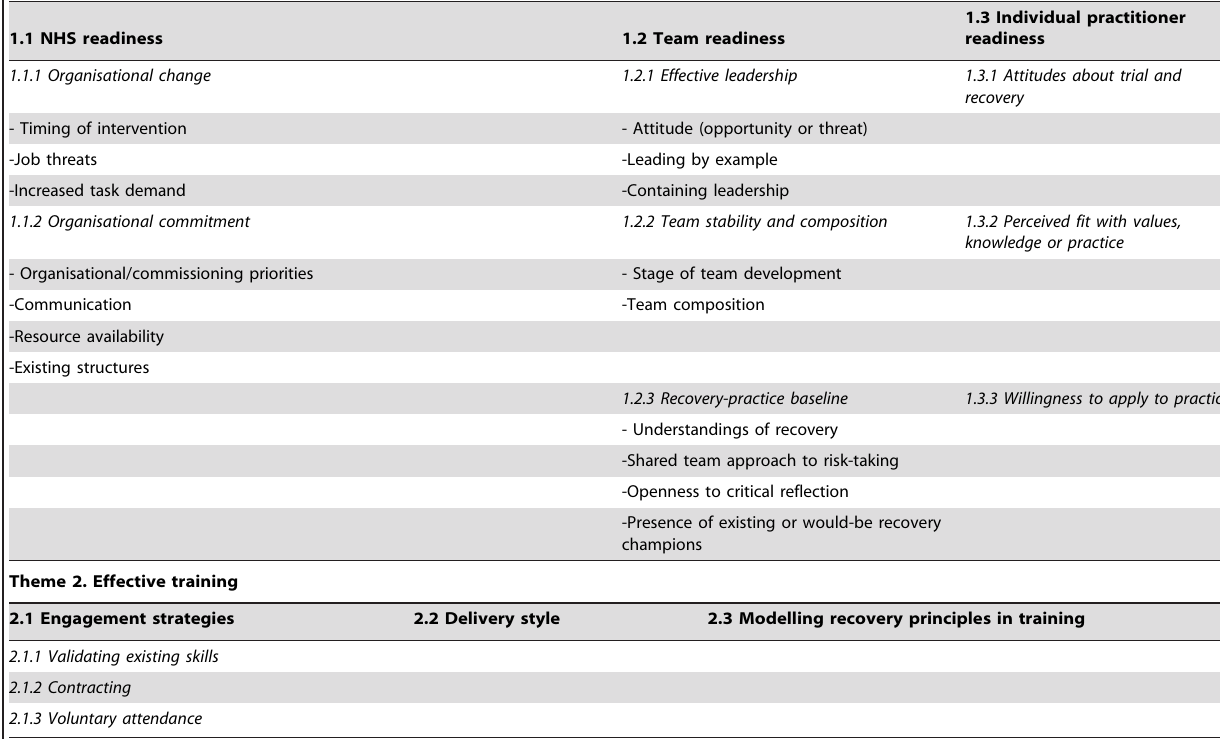
Theme 1. Organisational readiness for